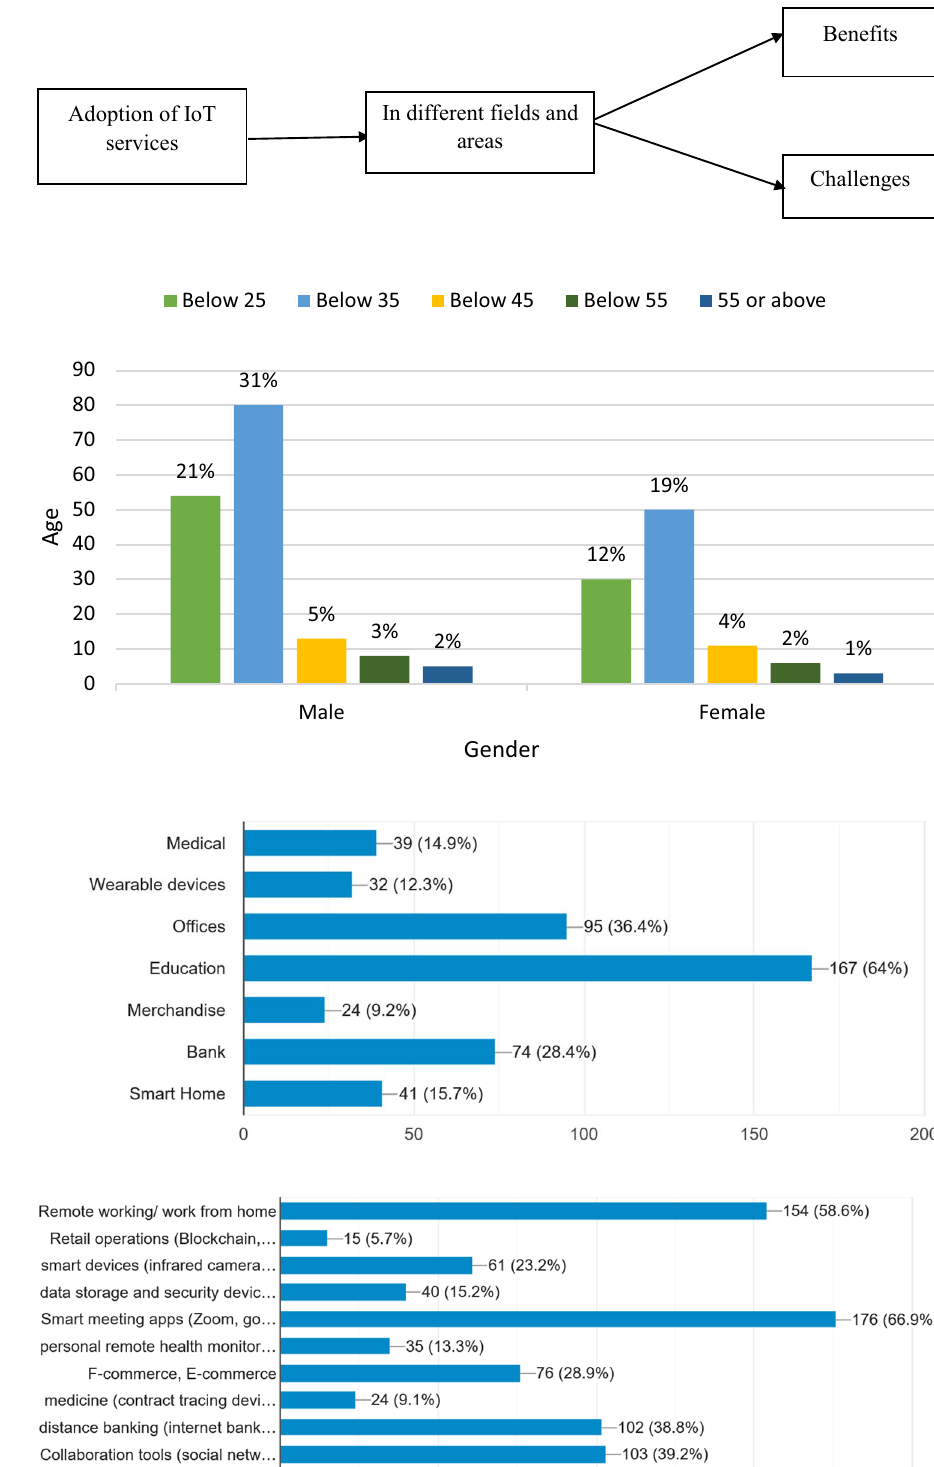
Fig. 5 Research Framework